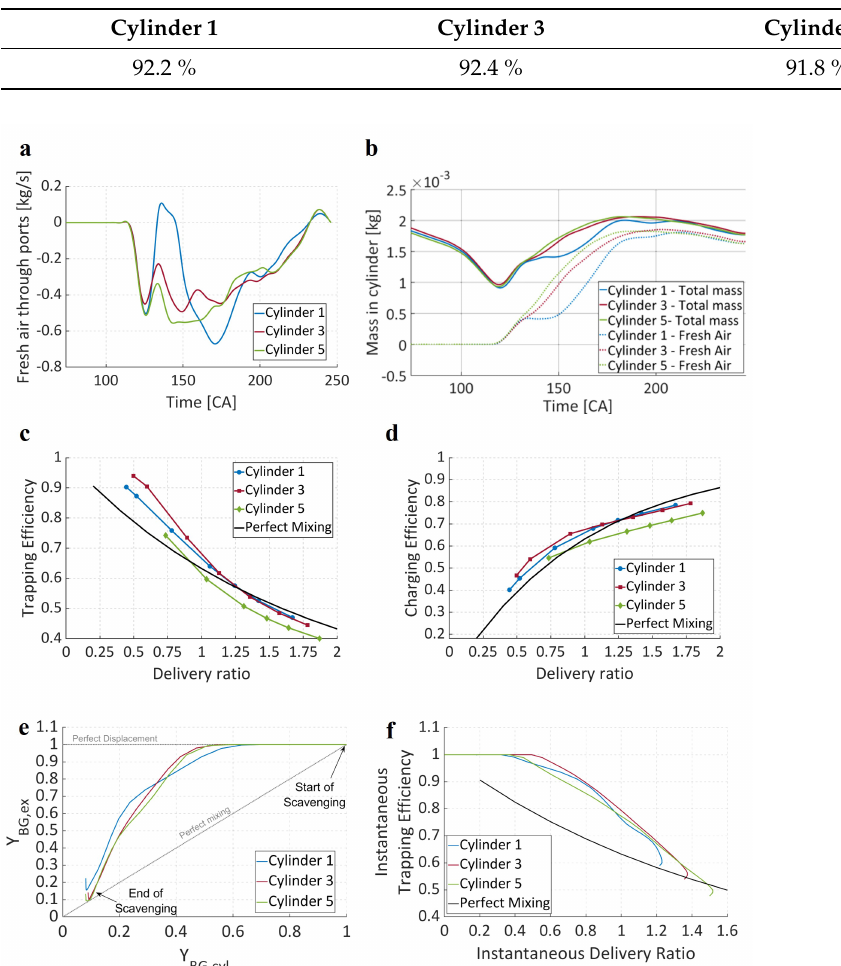
Table 4. Mass fraction of fresh air trapped within Cylinder 1, 3 and 5 at CA = 246 ◦ with respect to the in-cylinder total mass.